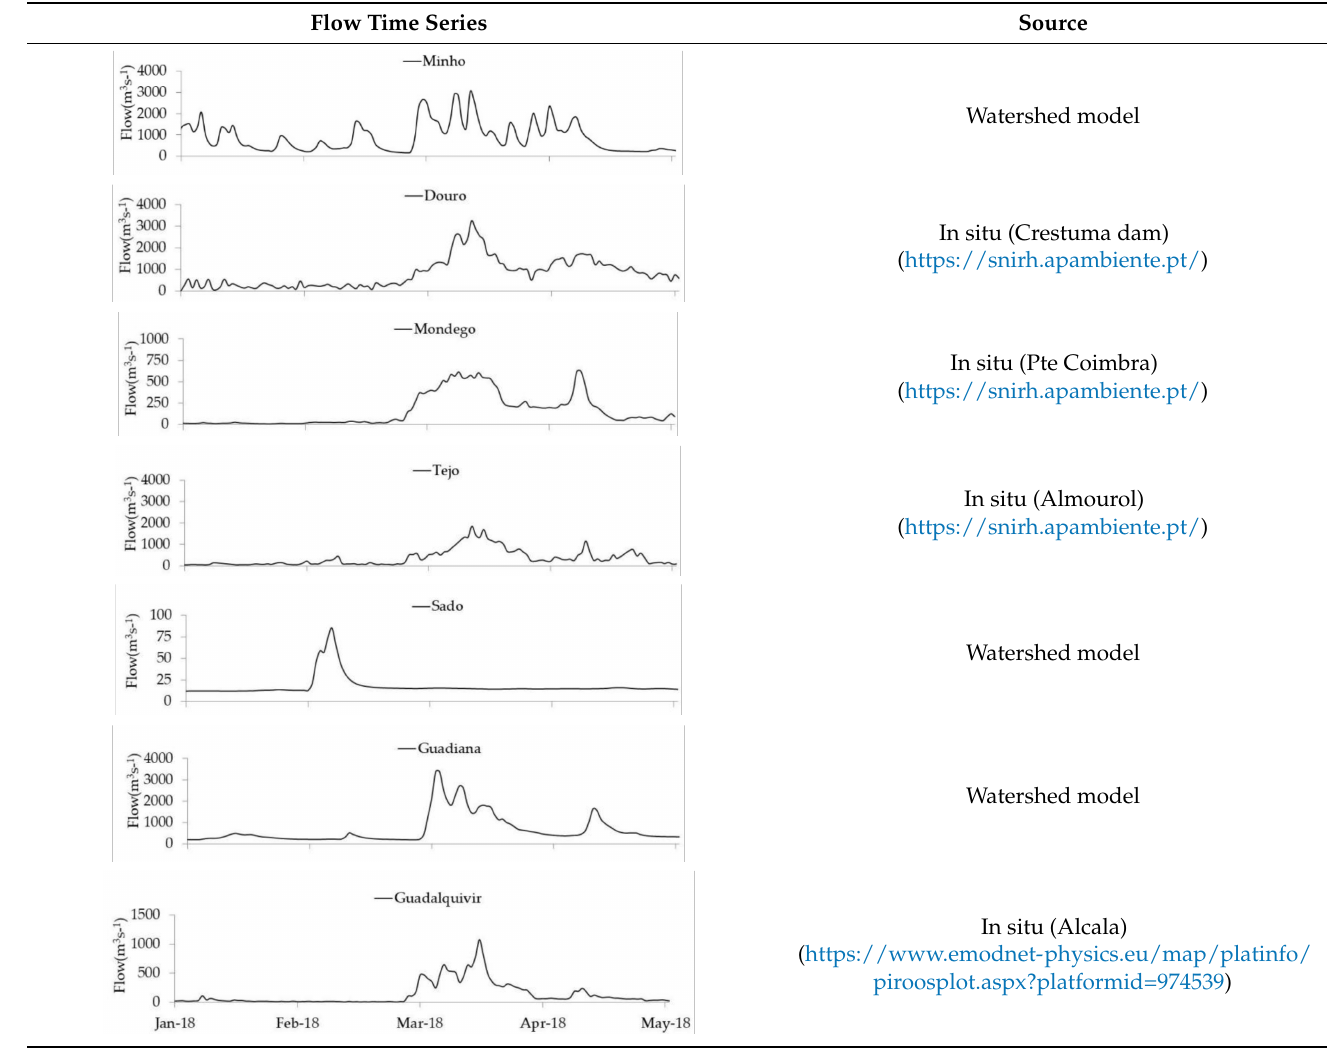
Table 3. River flow between January and May of 2018 and respective source of data used to feed the schematic